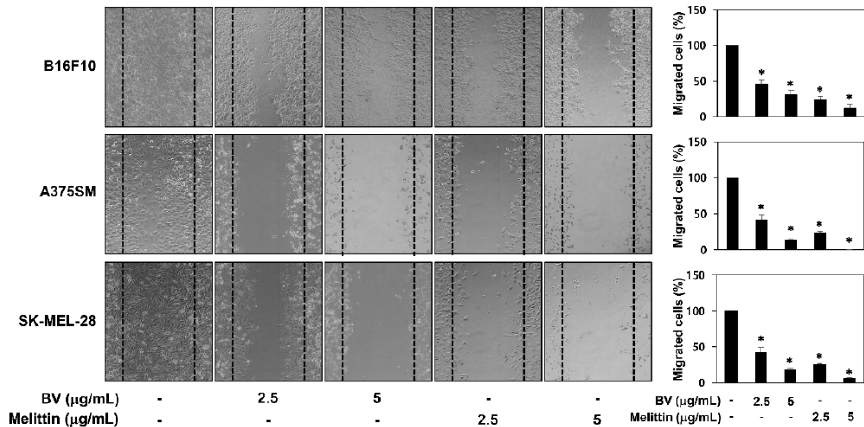
Figure 3. The effect of BV and melittin on the migration of melanoma cell lines. The migratory potential of melanoma cells was analyzed using wound healing assay. Cells were treated with BV and melittin for 24 h. Dotted black lines indicate the edge of the gap at 0 h. * p < 0.05 versus the control. Each value represents the mean ± SE from three independent